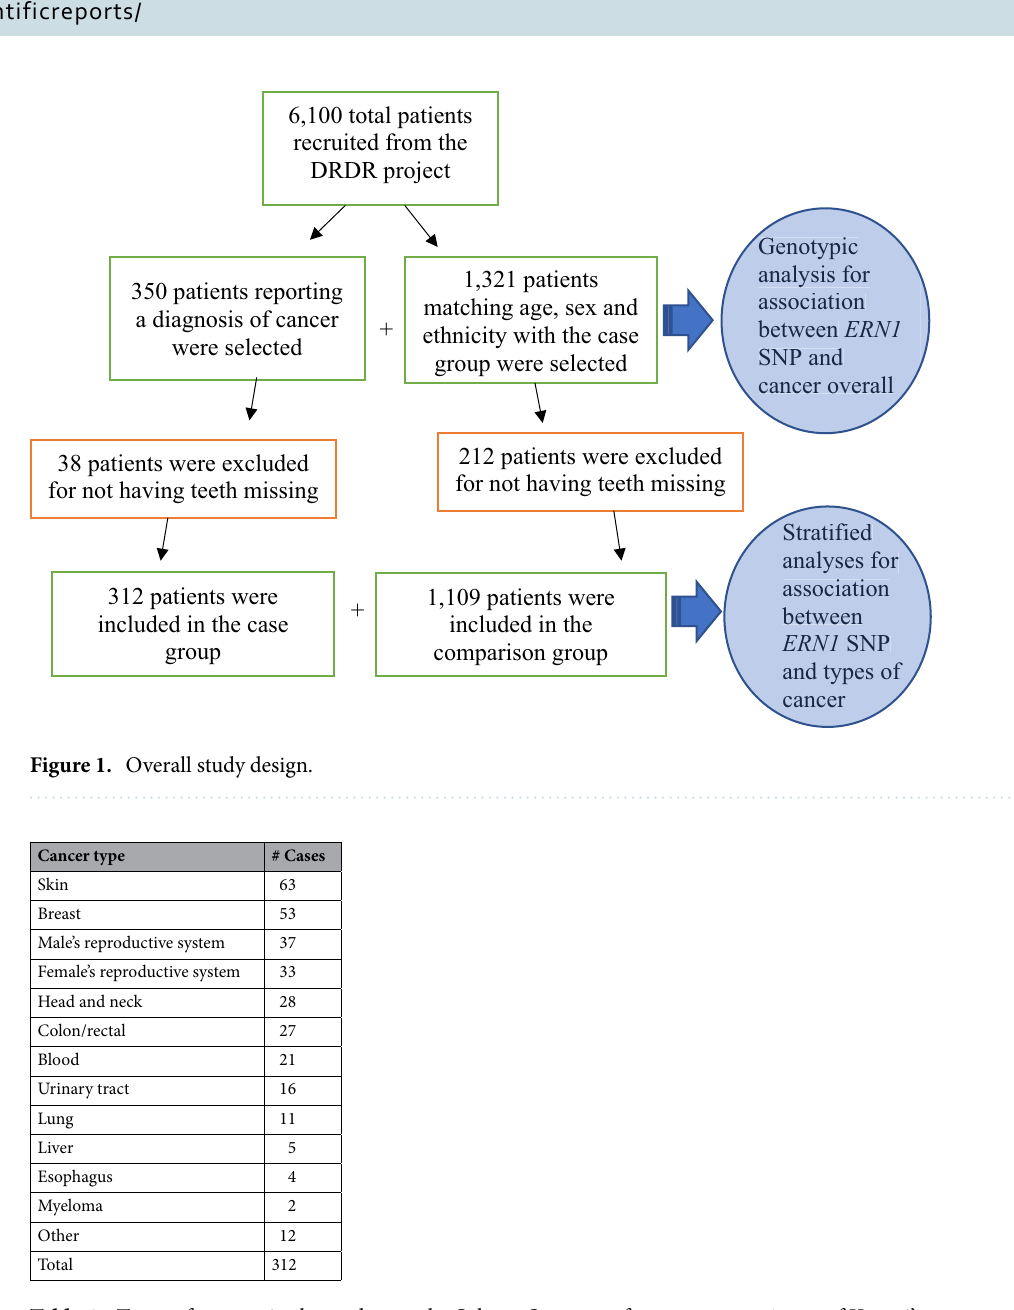
Table 4. Types of cancers in the study sample. Other = One case of osteosarcoma, 1 case of Kaposi’s sarcoma, 1 case of chest wall carcinoma, 1 case of stomach cancer, 1 case of liposarcoma, 7 unknown